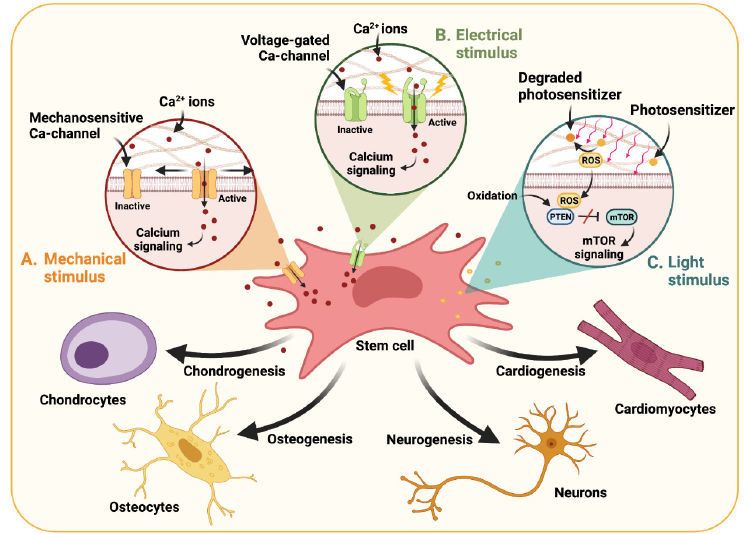
Figure 4. Schematic of the modulating effect of ( A ) mechanical, ( B ) electrical, and ( C ) light stimuli on the activation of specific signaling pathways that direct differentiation profiles of stem cells. Specific stimulation regimes that mimic mech- anotransductional or electrical cues in embryonic development can activate calcium signaling. Similarly, ROS production upon light stimulation can promote the oxidation of PTEN, a strong inhibitor of mTOR, and thus upregulate mTOR sig- naling [121]. (Created with BioRender.com).